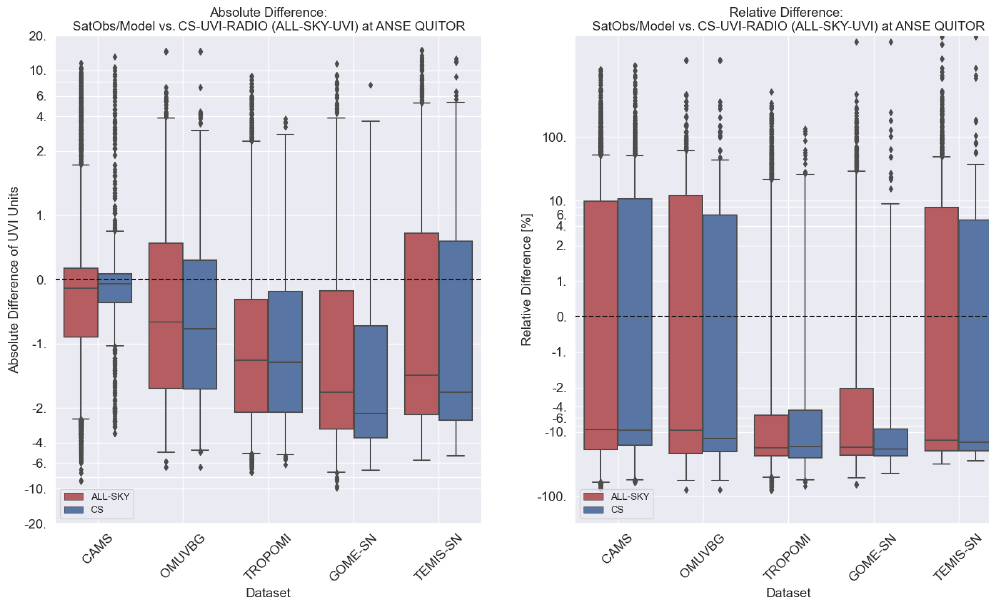
Figure A8. Boxplot of differences between UVI-RADIO and satellite/model estimates at Anse Quitor.